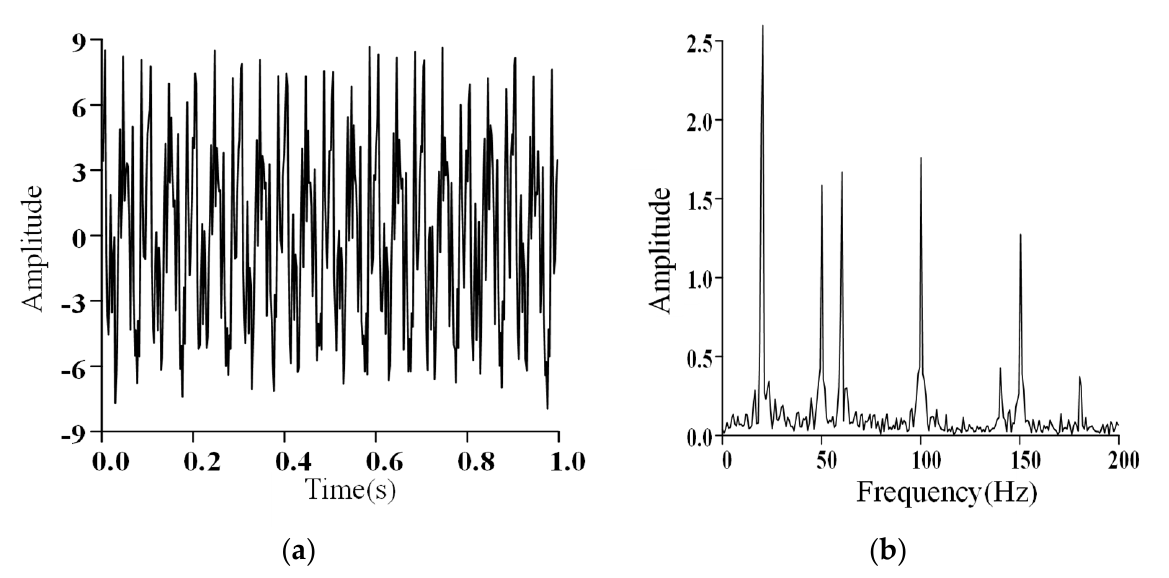
Figure 3. Synthetic vibration signal and its frequency spectrum. ( a ) Synthetic vibration signal ( b ) Synthetic − vibration − signal frequency spectrum.